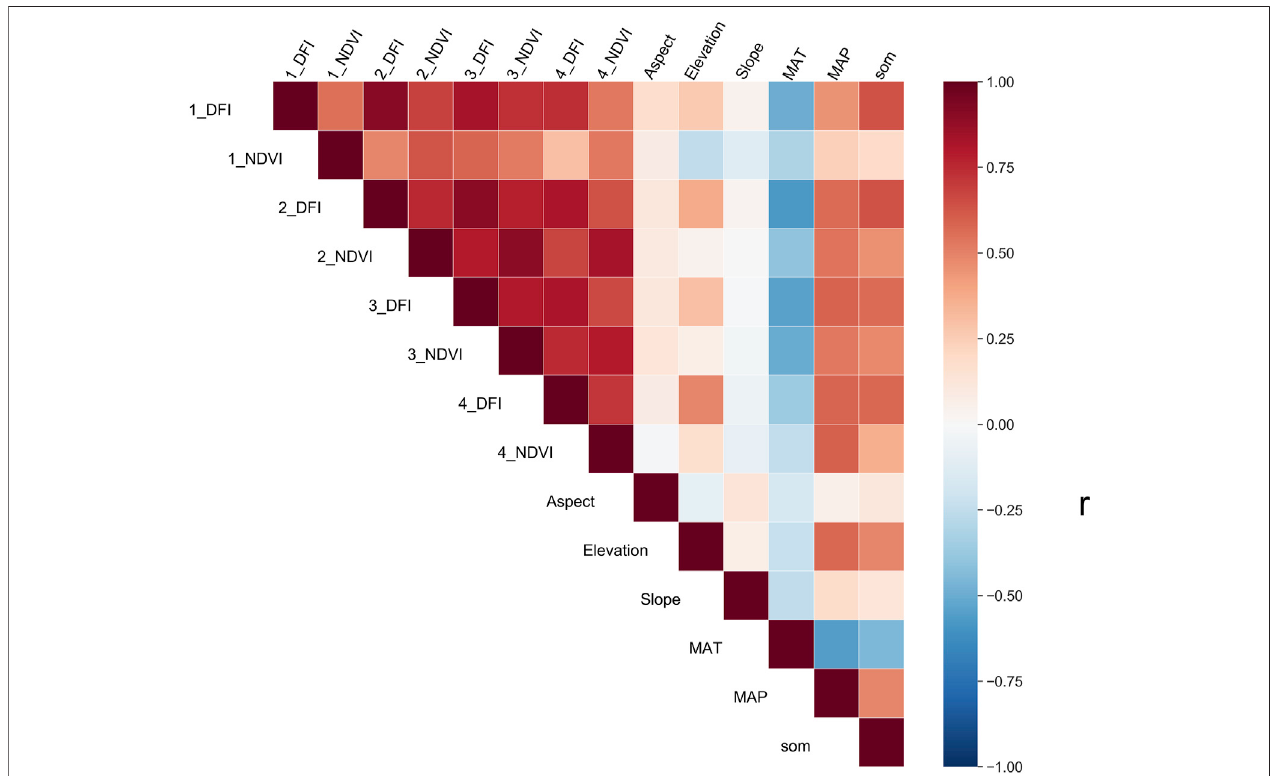
FIGURE 3 | Correlations between variables, indicating that the variables are signi fi cantly correlated at the 0.01 level. MAT: Mean annual temperature; MAP: Mean annual precipitation; 1_NDVI: Normalized difference vegetation index (NDVI) in the fi rst quarter; 2_NDVI: NDVI in the second quarter; 3_NDVI: NDVI in the third quarter; 4_NDVI: NDVI in the fourth quarter; 1_DFI: Dead fuel index (DFI) in the fi rst quarter; 2_ DFI: DFI in the second quarter; 3_ DFI: DFI in the third quarter; 4_ DFI: DFI in the fourth quarter; SOM: Soil organic matter